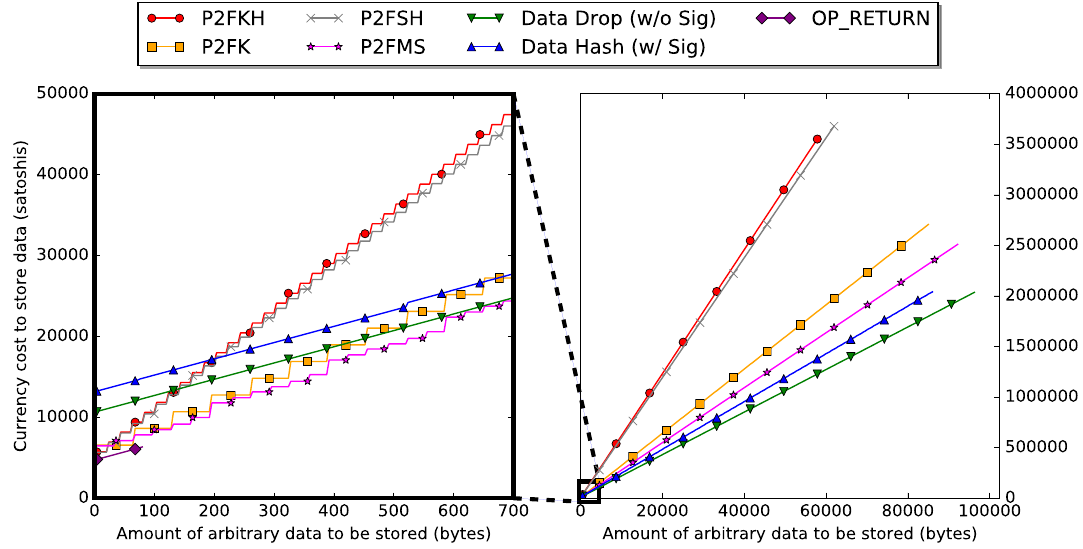
Fig. 4. Total data required vs. stored data size, for small (LEFT) and large (RIGHT) data sizes, up to the maximum size possible within a single transaction.